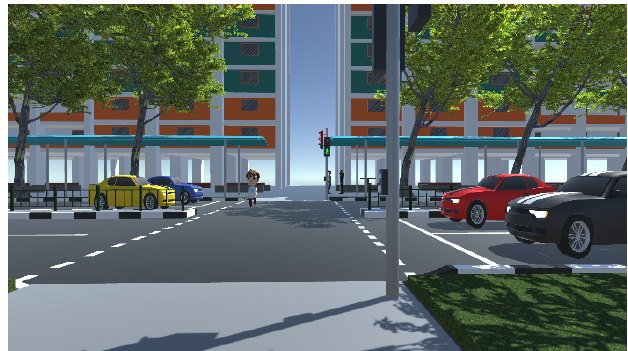
Figure 3. Game scene of the traffic light crossing.